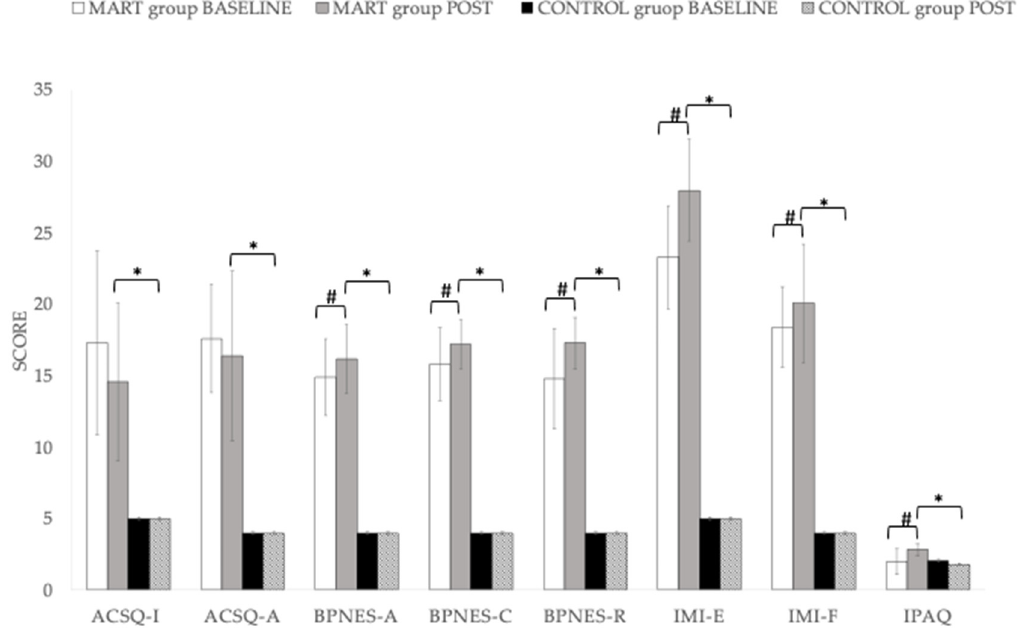
Figure 3. Sample characteristics at baseline and post-intervention. ACSQ-I = ACSQ Interest in the athlete’s opinion; ACSQ-A = Assessment of autonomous behavior; BPNES-A = Basic Psychological Needs in Exercise Scale—Autonomy; BPNES-C = Basic Psychological Needs in Exercise Scale—Competence; BPNES-R = Basic Psychological Needs in Exercise Scale— Relationship with others; IMI-E = Intrinsic Motivation Inventory—Enjoyment; IMI-F = Intrinsic Motivation Inventory— Effort; IPAQ = International Physical Activity Questionnaire; * = Significant difference between MART group vs. control group; # = Significant difference baseline vs. final. Differences were significant at p < 0.005.